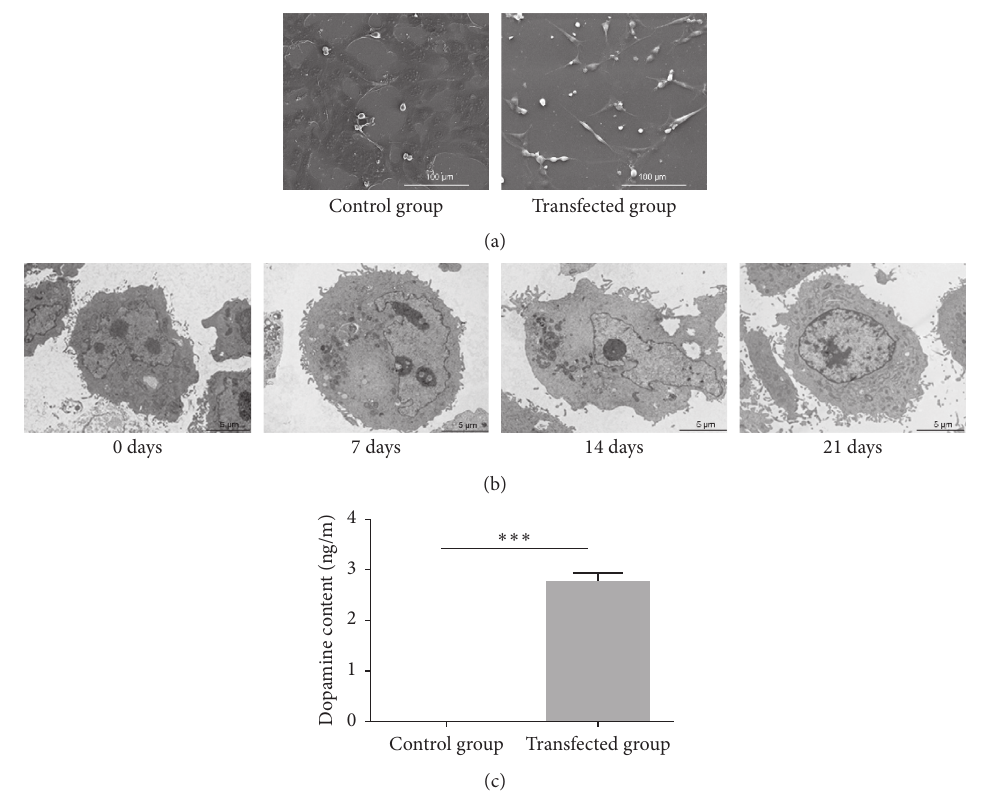
Figure 2: Identification of dopaminergic neurons differentiated from h-BMSCs. (a) Scanning electron microscopy showing ultrastructural characteristics of the transfection group changed after 21 days of induction. Scale bar � 100 μ m. (b) Transmission electron microscopy results showing ultrastructural characteristics of the transfection group changed after 7, 14, and 21 days. Scale bar � 5 μ m. (c) Dopamine expression of the transfection group significantly increased relative to the control group after 21 days of incubation. ∗∗∗ P < 0 .